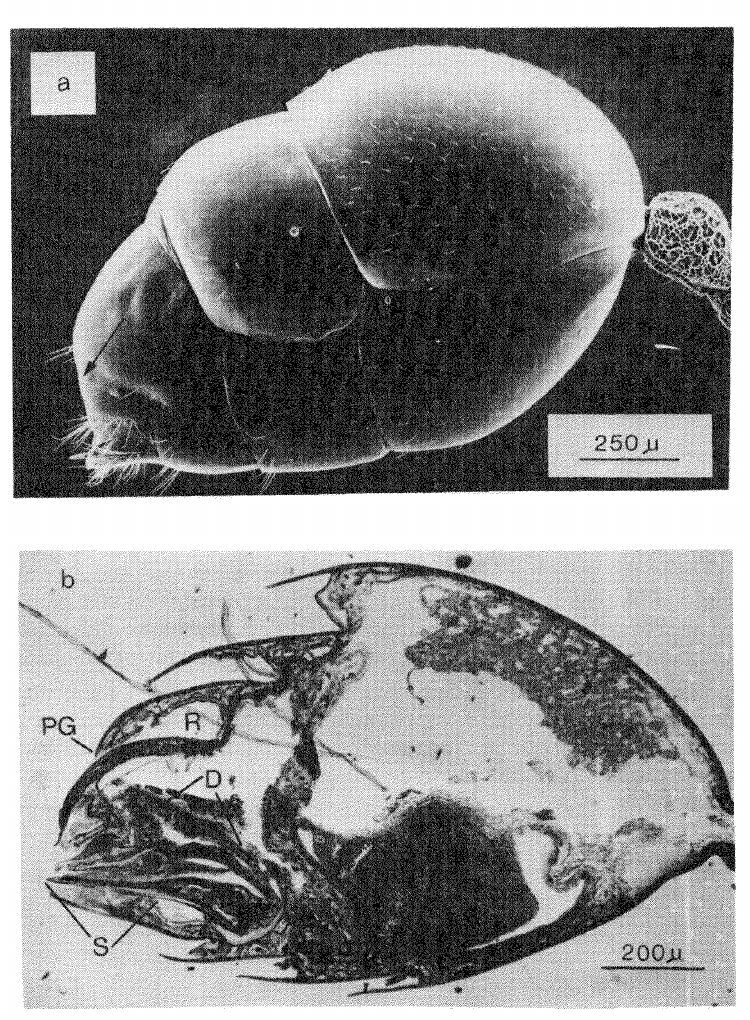
Fig. 3. Gaster of a media of Orectognathus versicolor. (a) SEM picture; arrow indicates opening of pygidial gland. (b) Sagittal section through gaster of a media. PG pygidial gland; R reservoir of pygidial gland; D Dufour’s gland; S